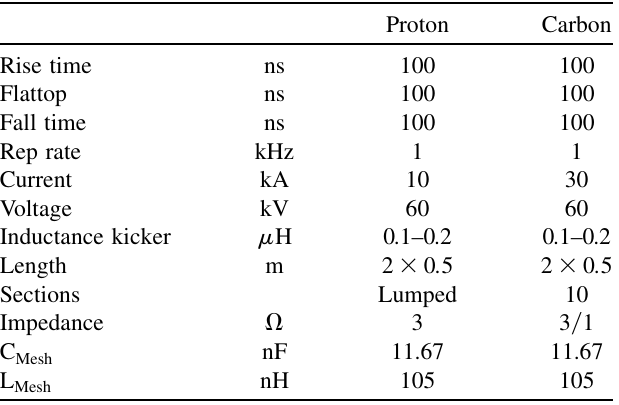
TABLE XXII. Specification of the PAMELA